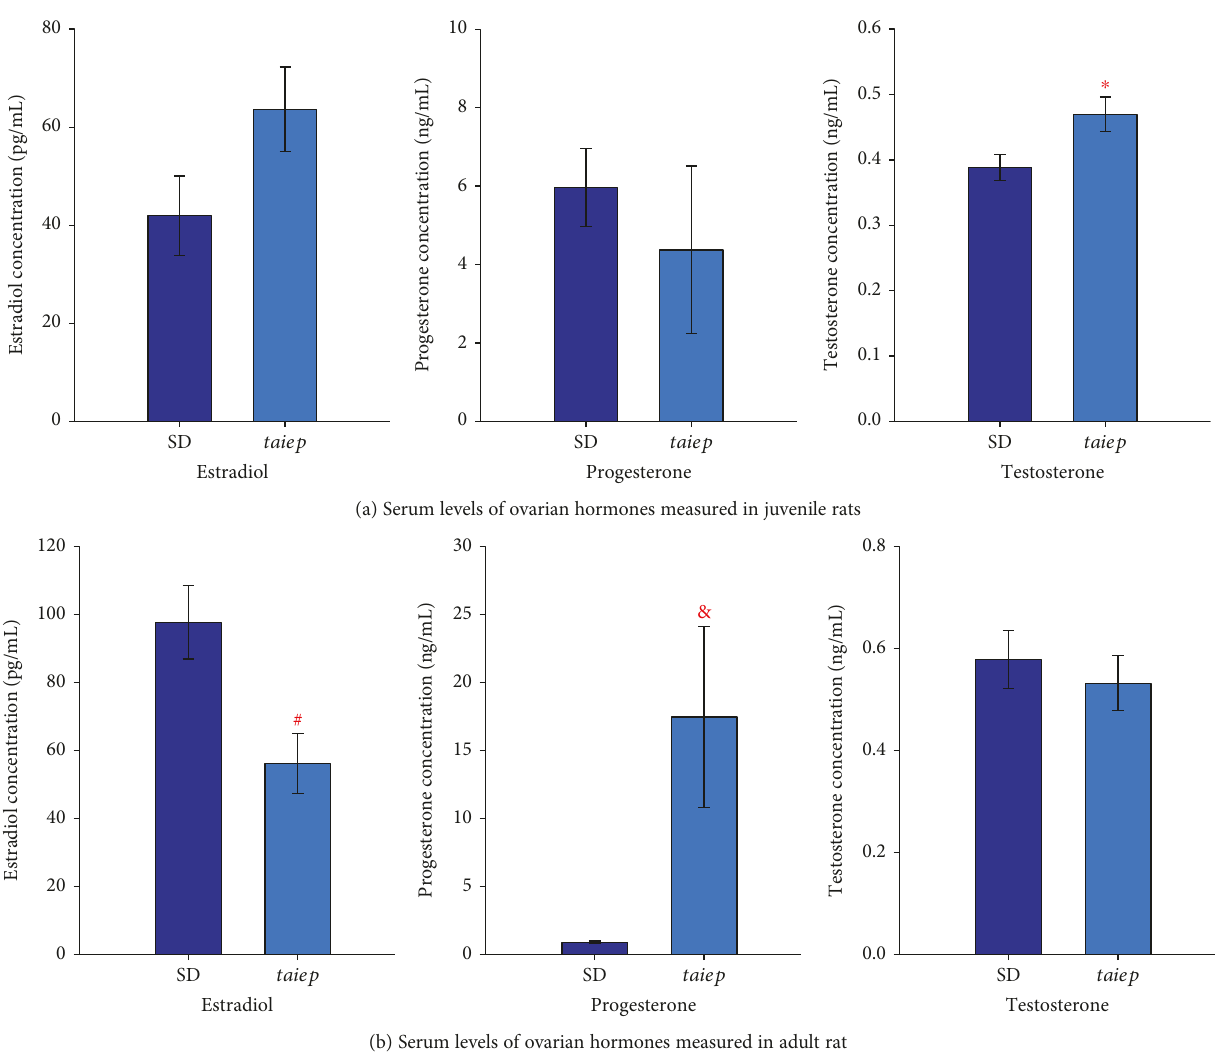
Figure 4: Serum levels of ovarian hormones in the juvenile and adult Sprague – Dawley and taiep rats. (a) Serum levels of estradiol, progesterone, and testosterone in the juvenile Sprague – Dawley and taiep rats. The error bars represent the standard error of measurements for 6 Sprague – Dawley rats (SD) or taiep rats. (b) Serum levels of estradiol, progesterone, and testosterone in adult Sprague – Dawley and taiep rats. The error bars represent the standard error of measurements for 6 Sprague – Dawley rats (SD) or taiep rats. SD: Sprague – Dawley. ∗ p ≤ 0 033 , # p ≤ 0 009 , and & p ≤ 0 017 ; Student ’ s t